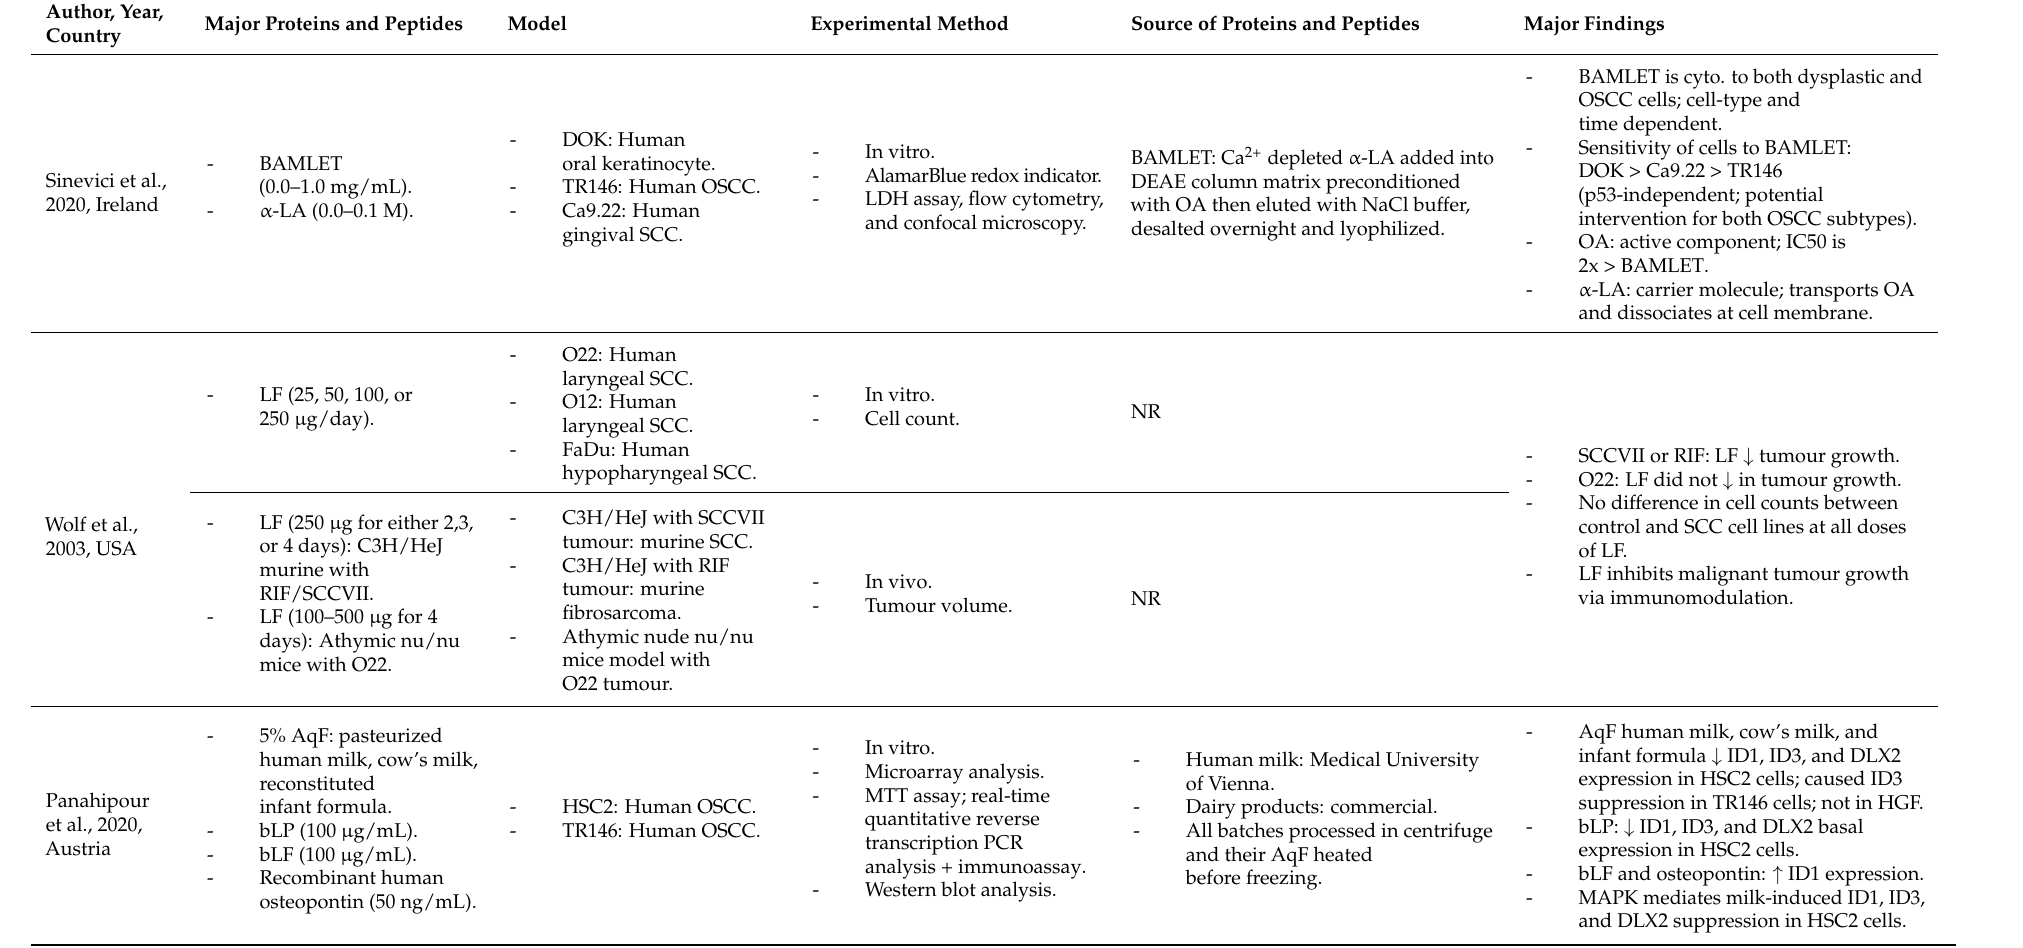
Table 1. Findings from 8 studies on milk-derived proteins and peptides on head and neck cancer cells.